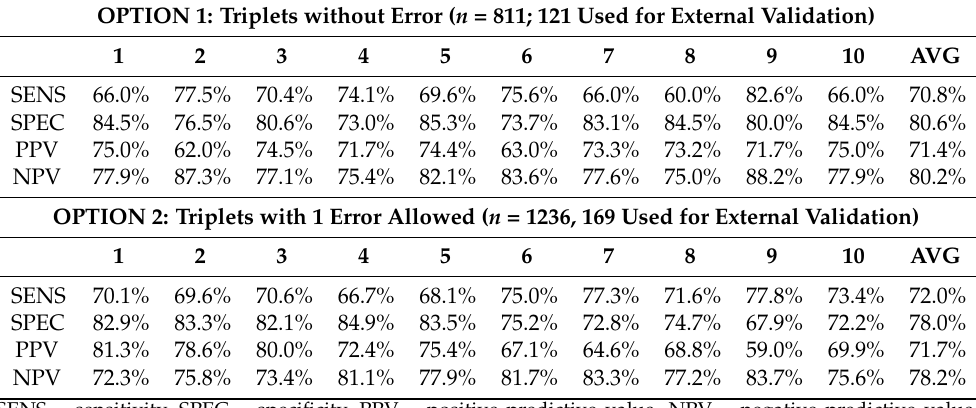
Table 1. Sensitivity, specificity, and positive and negative predictive values of 10 iterations considering both options: training/test with and without error